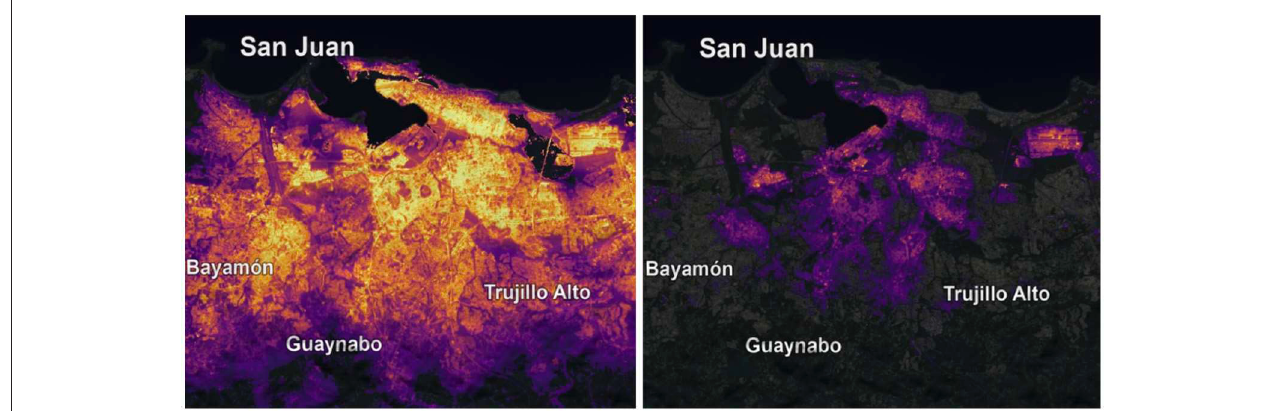
FIGURE 10 | Baseline (pre-storm) view of San Juan, Puerto Rico, nighttime lights (L) and average nighttime lights two months (Sep. 20 - Nov. 20, 2017) after Hurricane Maria (R) . (Credit: Kel Elkins, NASA Scientific Visualization